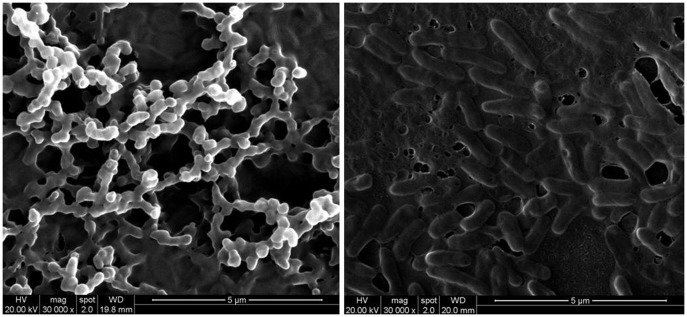
SEM of the strain Sm1219 of S. maltophilia biofilm mode in 8 h (left) and 24 h (right).